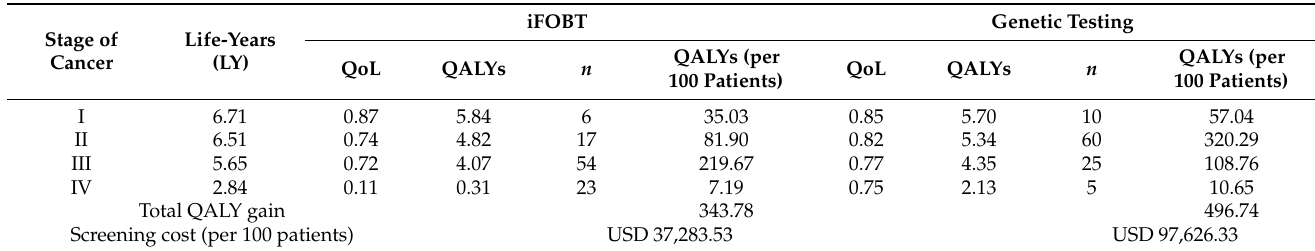
Table 6. Quality-adjusted life-years (QALYs) gained.